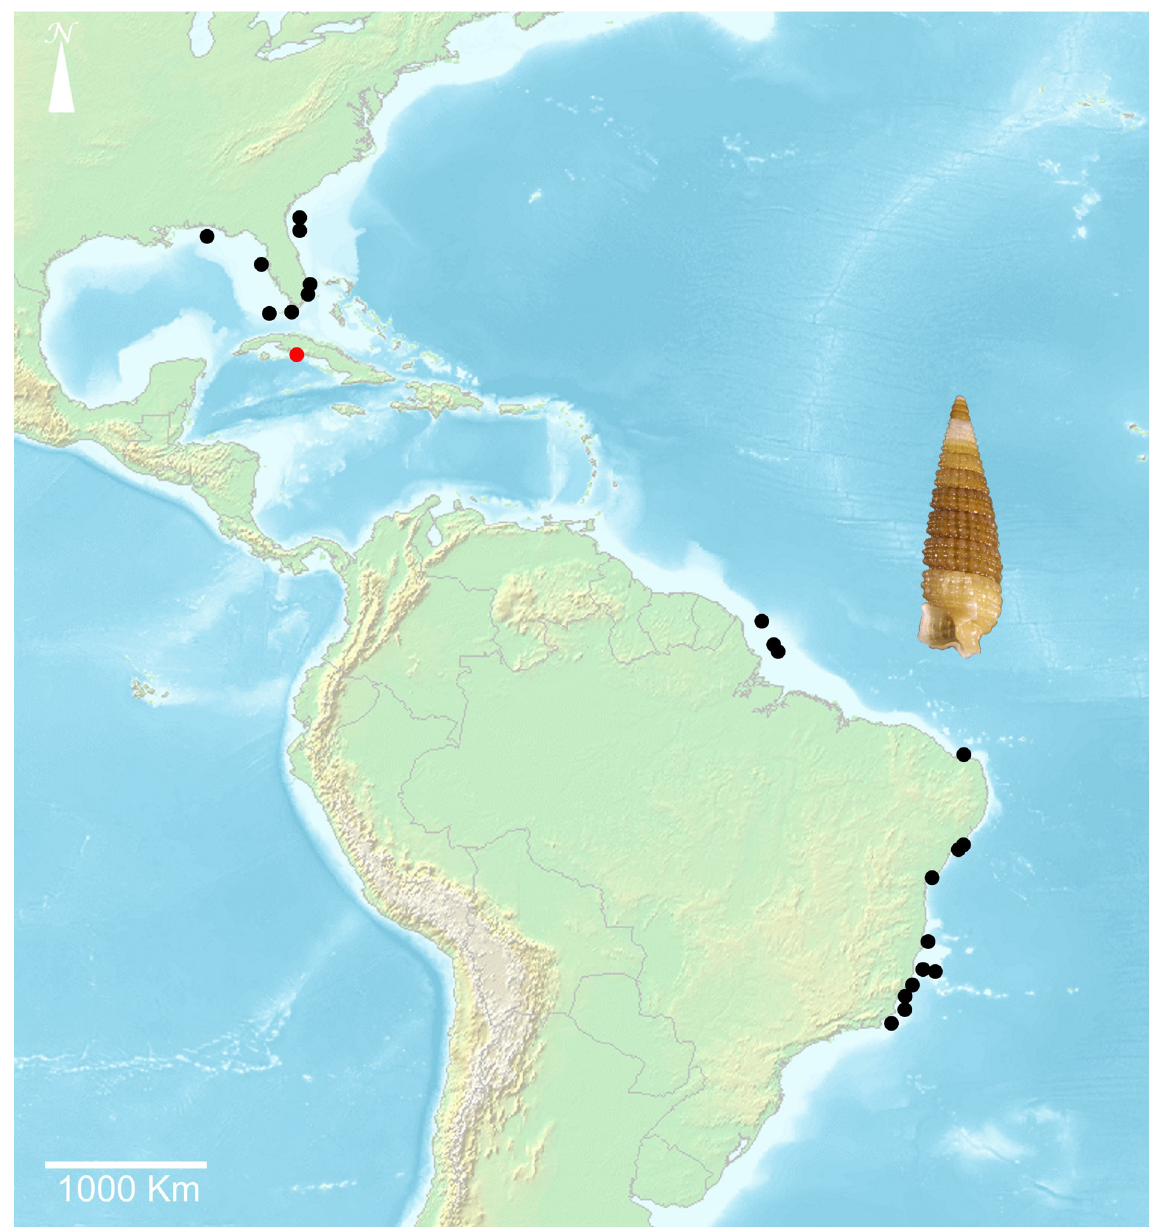
Fig. 54. Distribution map of Marshallora ostenta Rolán & Fernández-Garcés, 2008; red circle = type